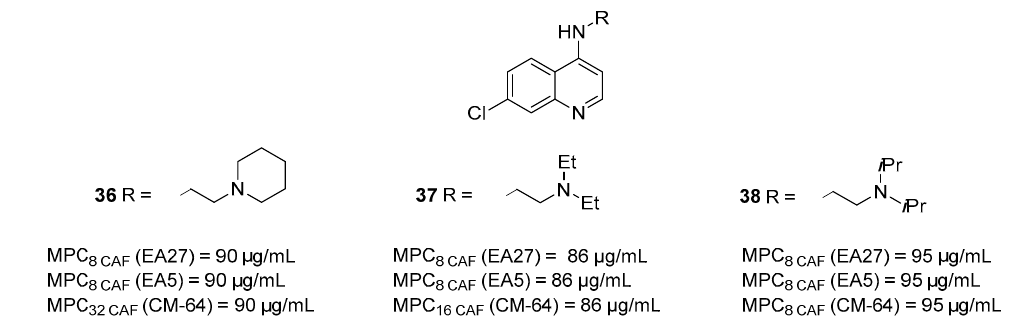
Figure 13. Quinoline derivatives ( 36 – 38 ) reported as Gram-negative EPIs.